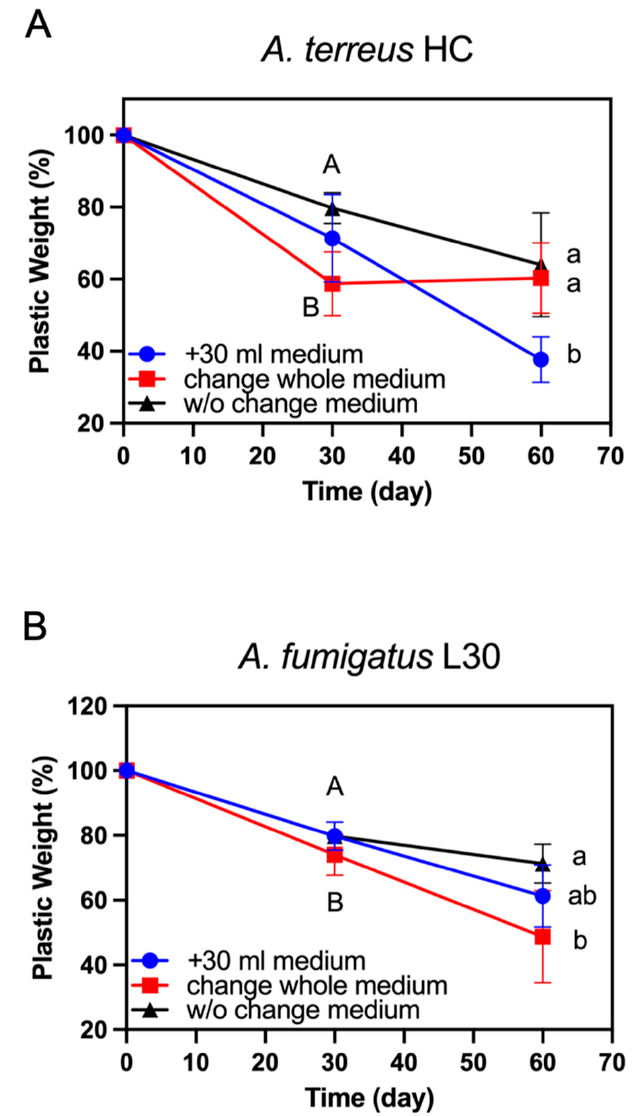
Figure 3. Determination of the effect of replacement or addition of fresh medium on PBSA plastic film degradation after 60 days of incubation. ( A ) Weight loss of PBSA film against time with A. fumigatus strain L30. ( B ) Weight loss of PBSA film against time with A. terreus HC. w/o medium change: maintaining the original medium during the whole incubation period (60 days); replacement of all culture medium (100 mL) or addition of 30 mL of fresh medium were carried out on the 30th day of incubation. The value of individual treatment is expressed as the row mean ± standard deviation. Statistical analyses were based on the degradation rates (g/day) on the 30th (in uppercase letters A and B) and 60th (in lowercase letters a and b) days of incubation.